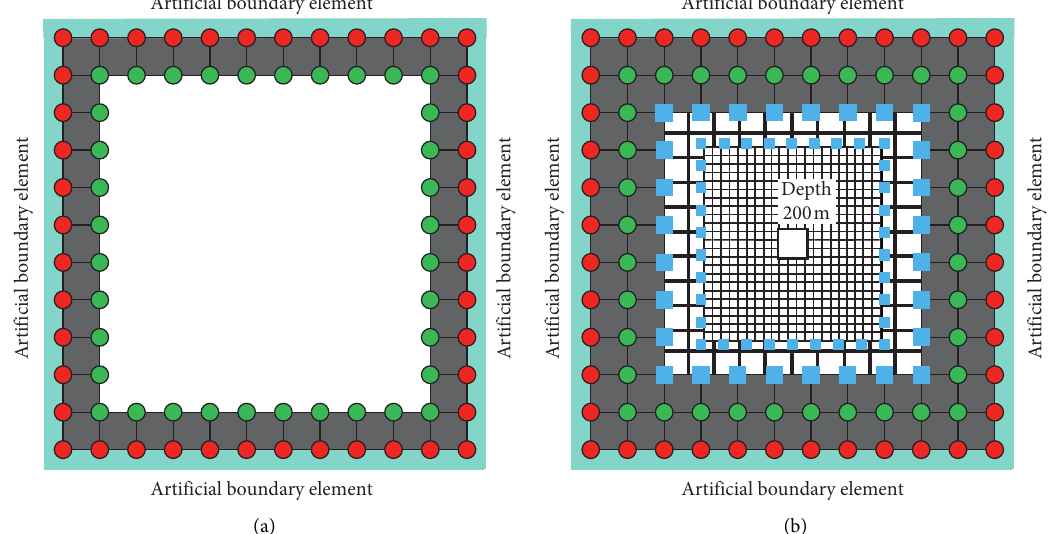
Figure 16: Model of Example 4.1.3 (burial depth is 200 m): (a) closed artificial boundary substructure, (b) SSI